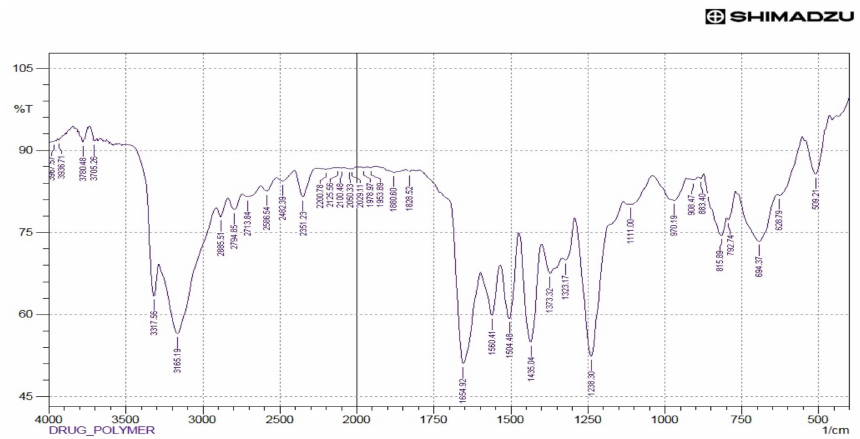
Figure 6. FTIR analysis of the mucilage (CGM) + paracetamol.